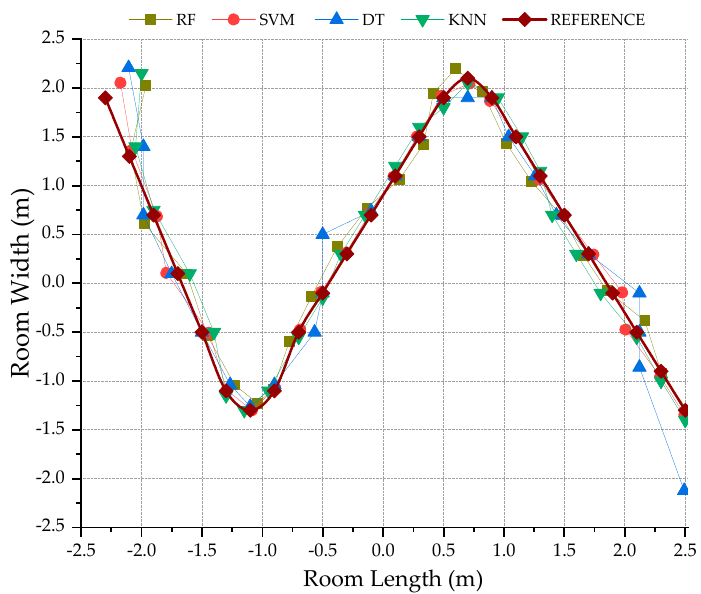
Figure 24. Estimated route before noise reduction and area division.